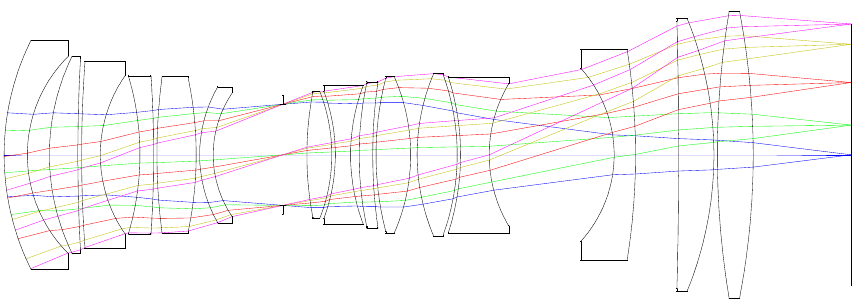
Figure 11. Optical layout of the final system.